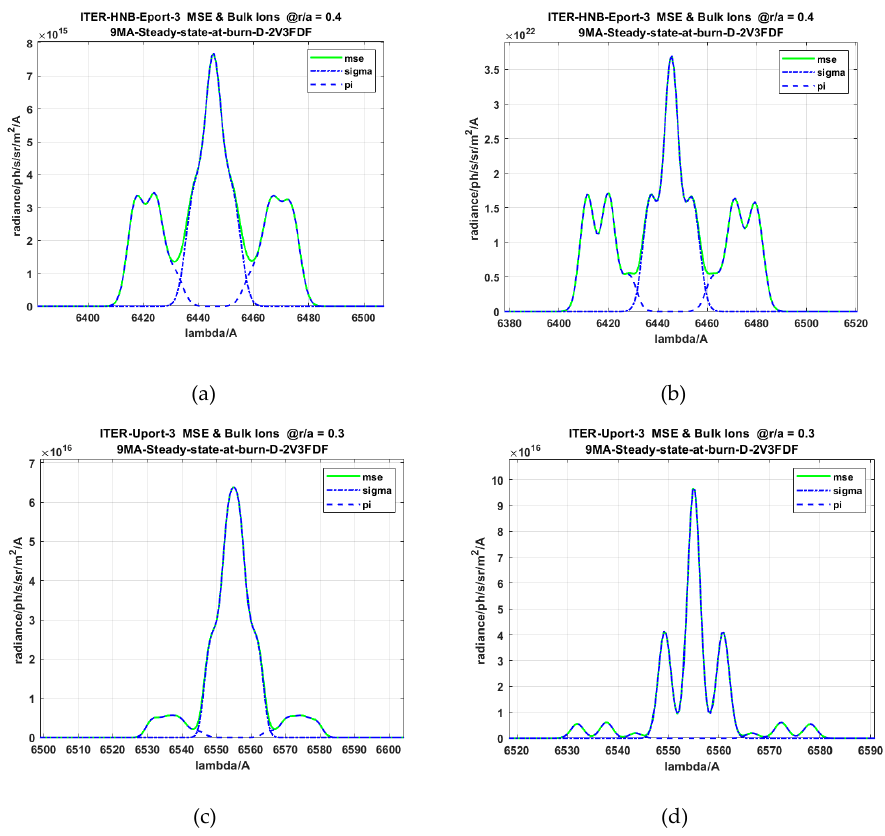
Figure 8. ( a ) asymmetric MSE spectrum, HNB 500 keV/amu, Finite Ion Grid presentation with 64 * 20 beamlets. ITER 9MA scenario, E-port-3, ρ = 0.4, dispersion is 0.85 nm/mm; ( b ) asymmetric MSE spectrum, HNB 500 keV/amu Single-Point Ion Grid presentation. ITER 9MA scenario, E-port-3, ρ = 0.4, dispersion is 0.85 nm/mm; ( c ) asymmetric MSE spectrum. DNB 100 keV/amu, Finite Ion Grid presentation with 64 * 20 beamlets with 5 mrad divergence. ITER 9MA steady state scenario, U-port-3, ρ = 0.3, disp = 0.55 nm/mm; ( d ) asymmetric MSE spectrum. DNB 100keV/amu.